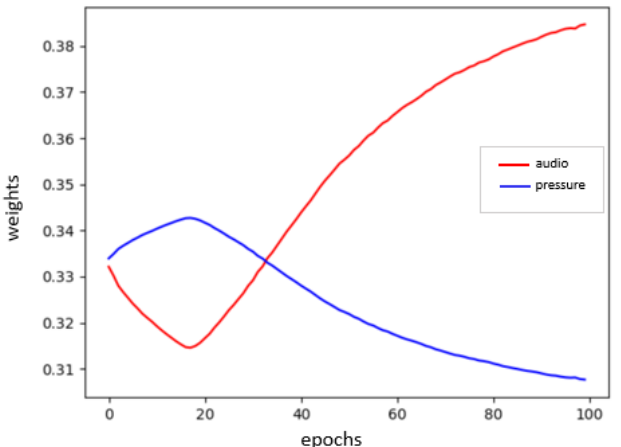
Figure 6. Evolution of the contribution parameters over 100 training epochs for the ToF/radar fusion system.